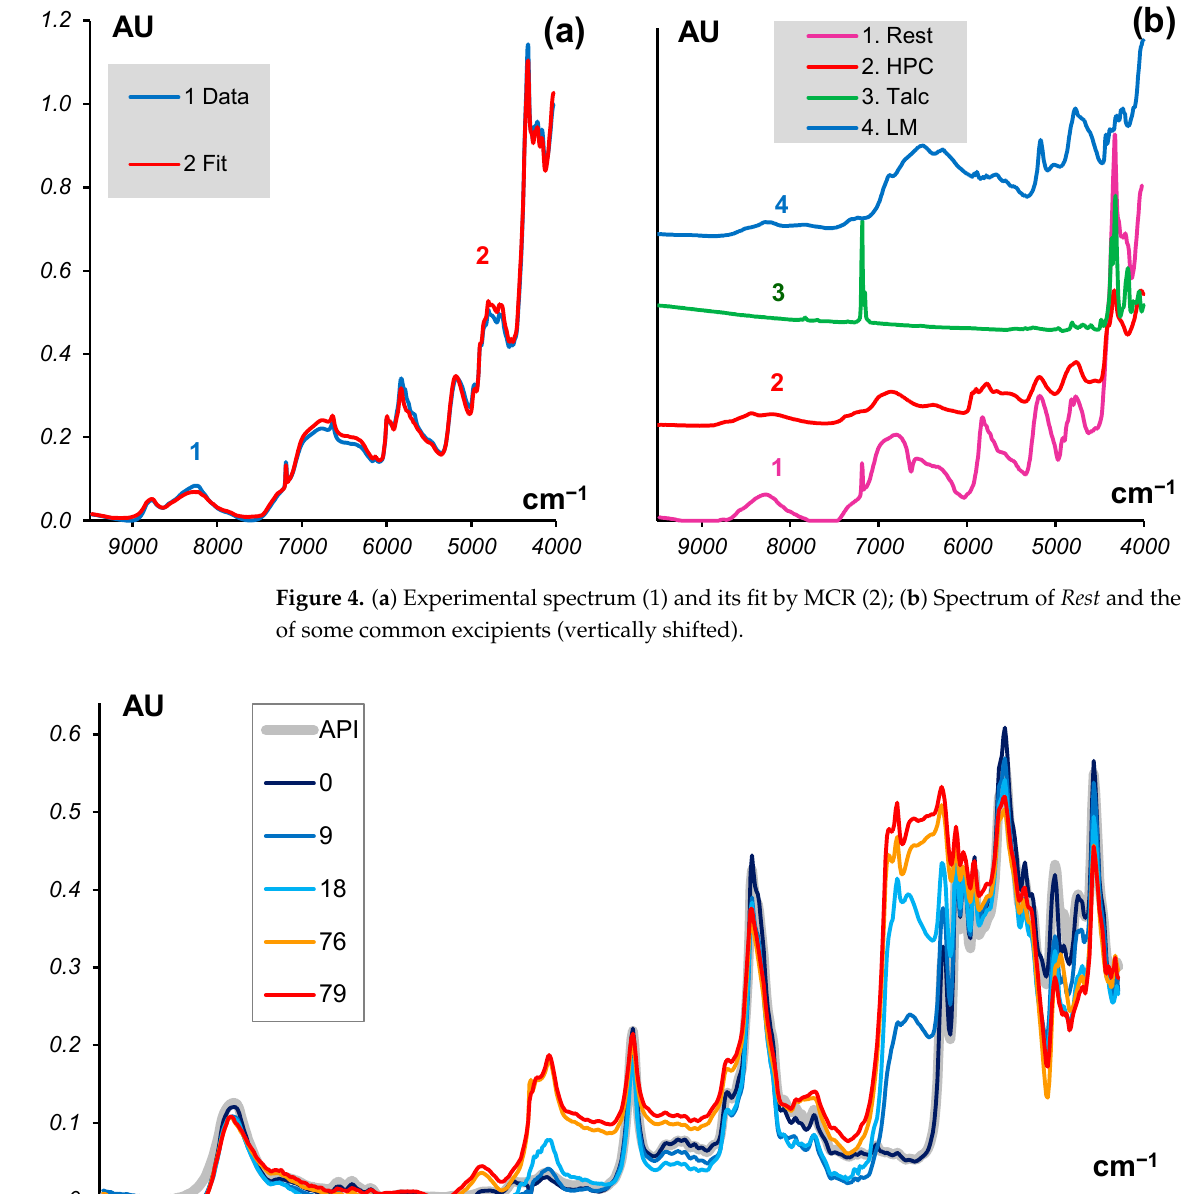
7 of 12 Figure 3. ( a ) Spectrum of Rest and spectra of other components; ( b ) Known ( API , MCC , Res t) and estimated ( PVC ) concentrations of components. The procedure converged with a good discrepancy that is characterized by a value of LoF = 1.7%. The left panel (a) of Figure 4 shows an example of the MCR fit for sample